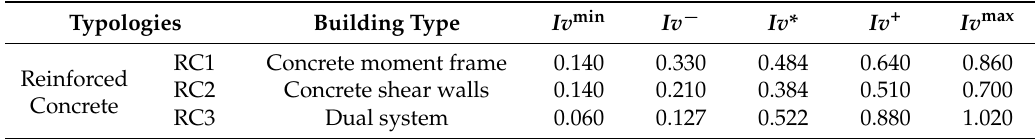
Table 1. Basic vulnerability indexes of reinforced concrete building typologies defined in Building Typology Matrix [18,24].